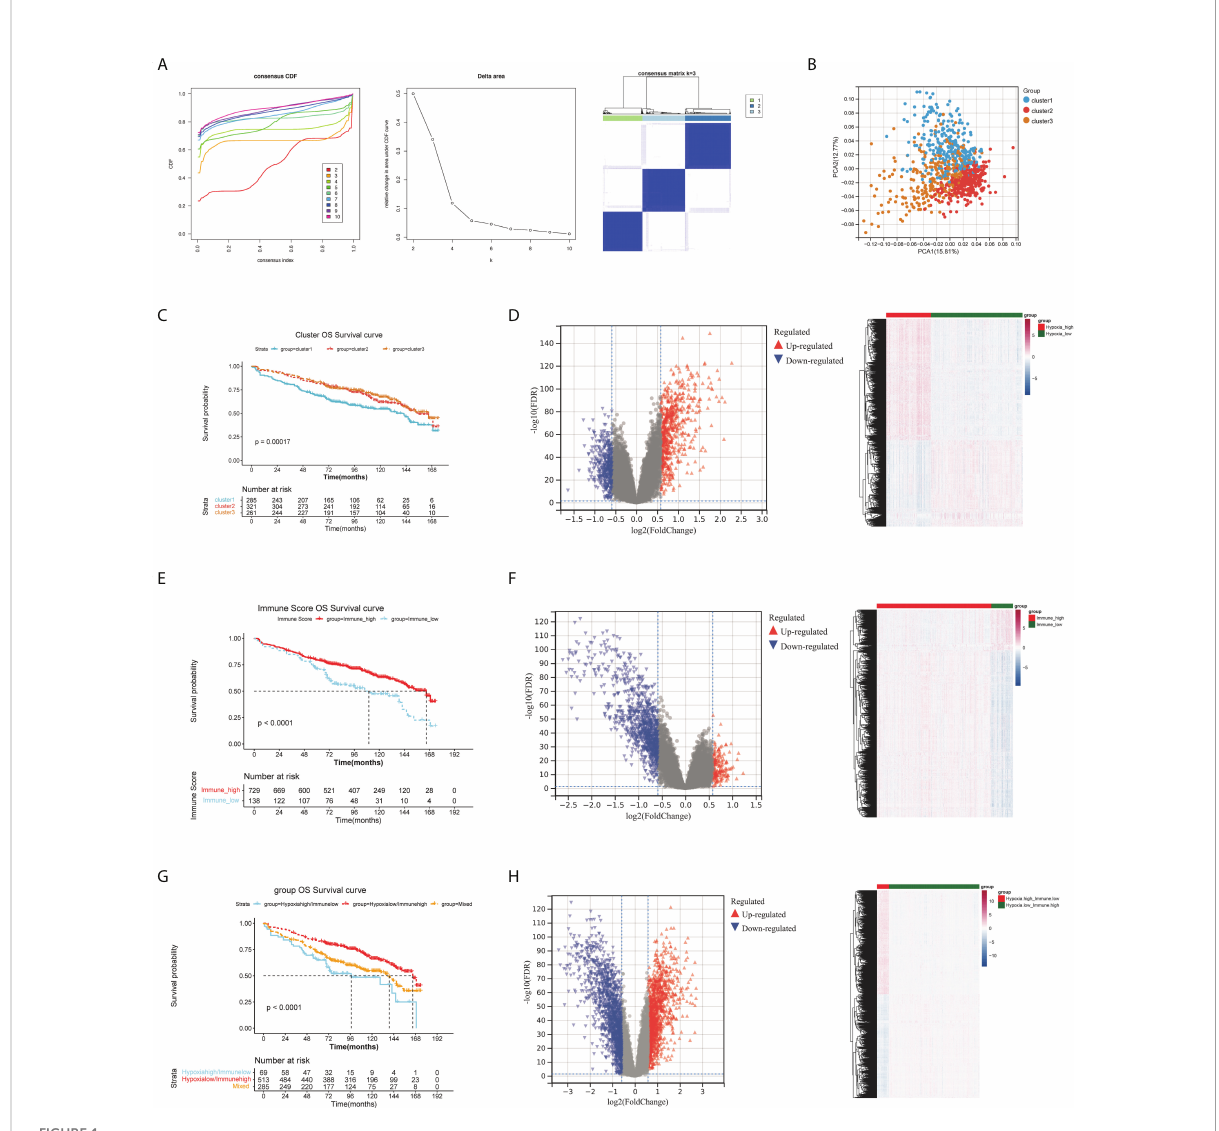
FIGURE 1 Differential expression analysis of HRGs, IRGs and H-IRGs. (A) The cumulative distribution function (CDF) value, the cluster diagram when K = 3. (B) Principal component analysis. (C) The K-M survival analysis among the three clusters. (D) Volcano plot and heatmap of DEGs between the HH and HL groups. (E) K-M analysis between the IMH and IML groups. (F) Volcano plot and heatmap of DEGs between the IMH and IML groups. (G) K-M analysis among the HL/IMH, HH/IML and mixed groups. (H) Volcano plot and heatmap of DEGs between the HL/IMH and HH/IML